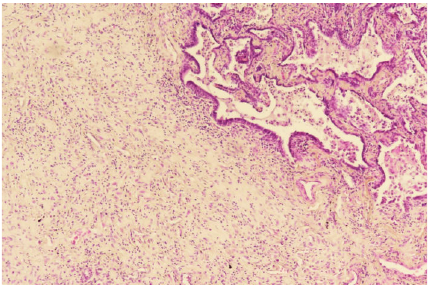
Figure 2: Histopathology ( × 100). Interstitial pneumonia.